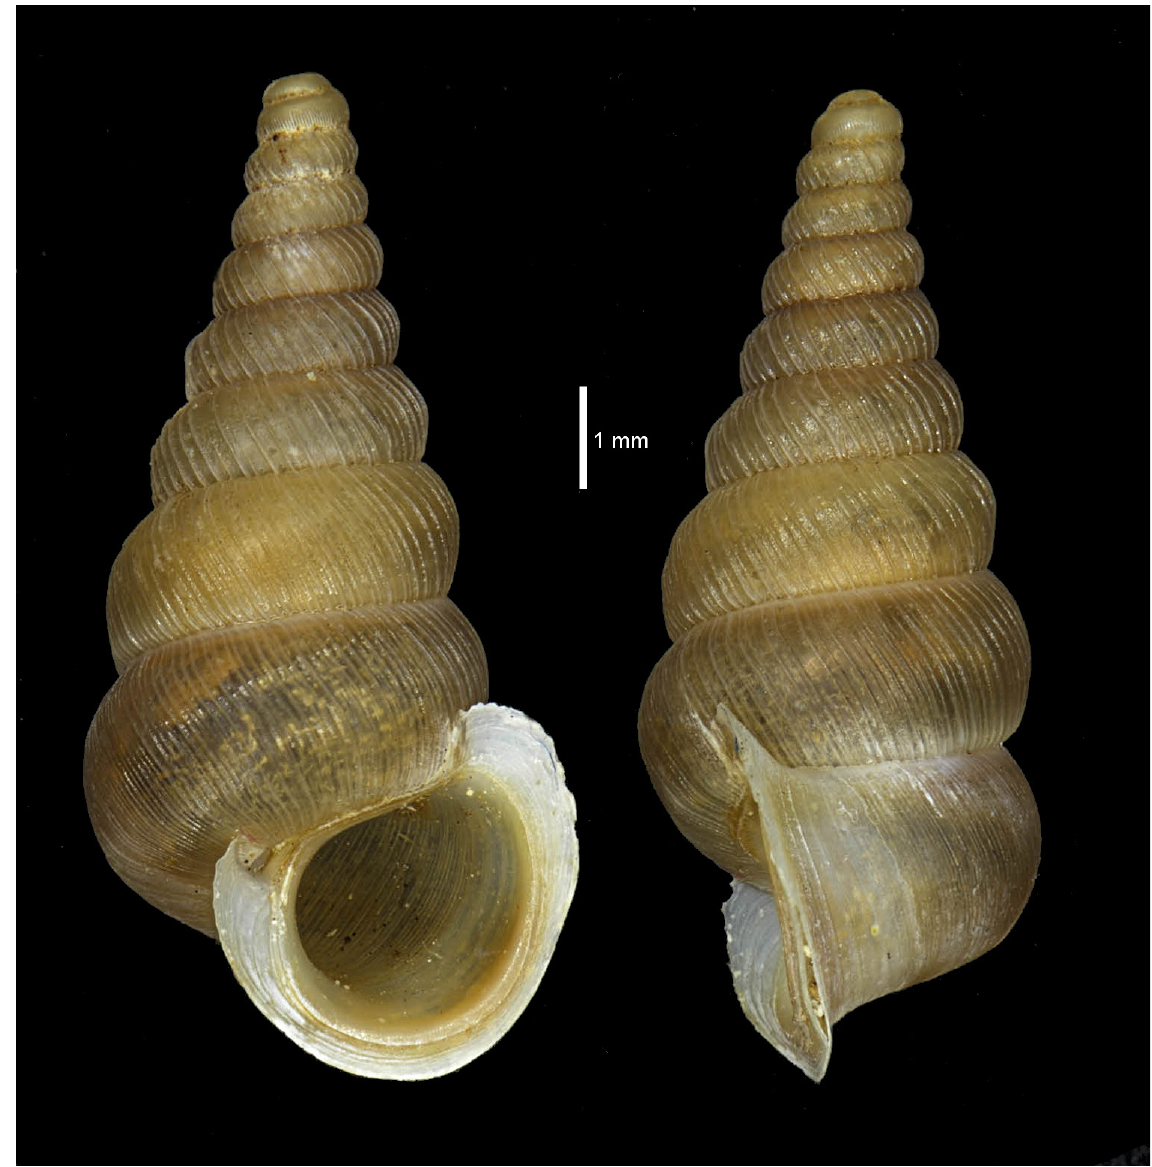
Fig. 7. Cochlostoma (Lovcenia) erika (A.J. Wagner, 1906), lectotype, “Popovo Höhle bei Njegus”, Montenegro (NHMW